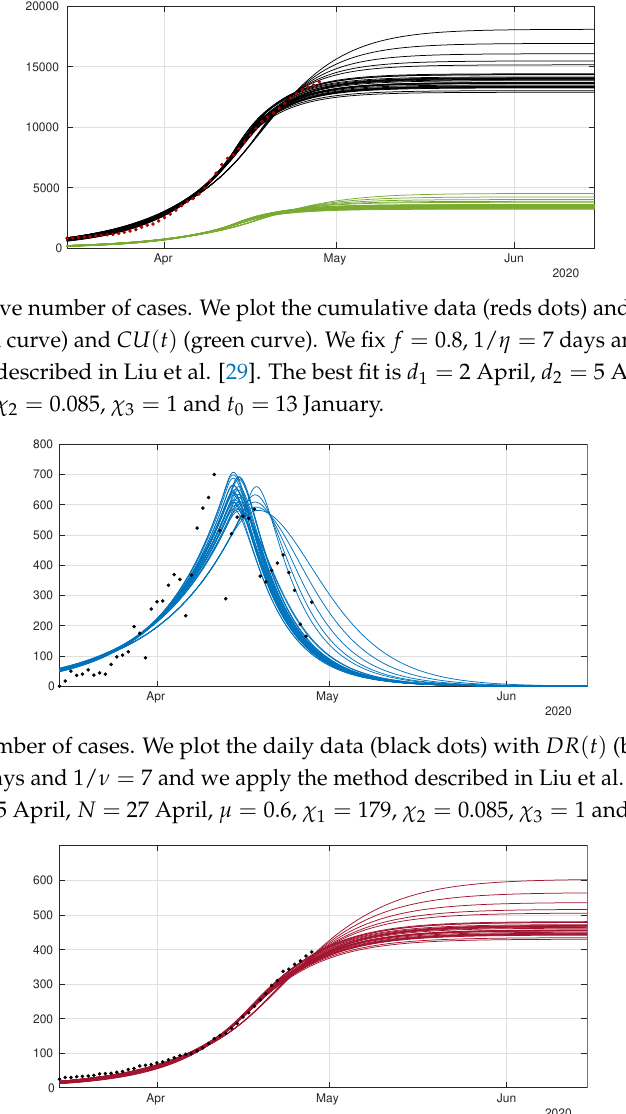
Figure 10. In this figure we plot the data for the cumulative number of death (black dots), and our best fits for D ( t ) (red